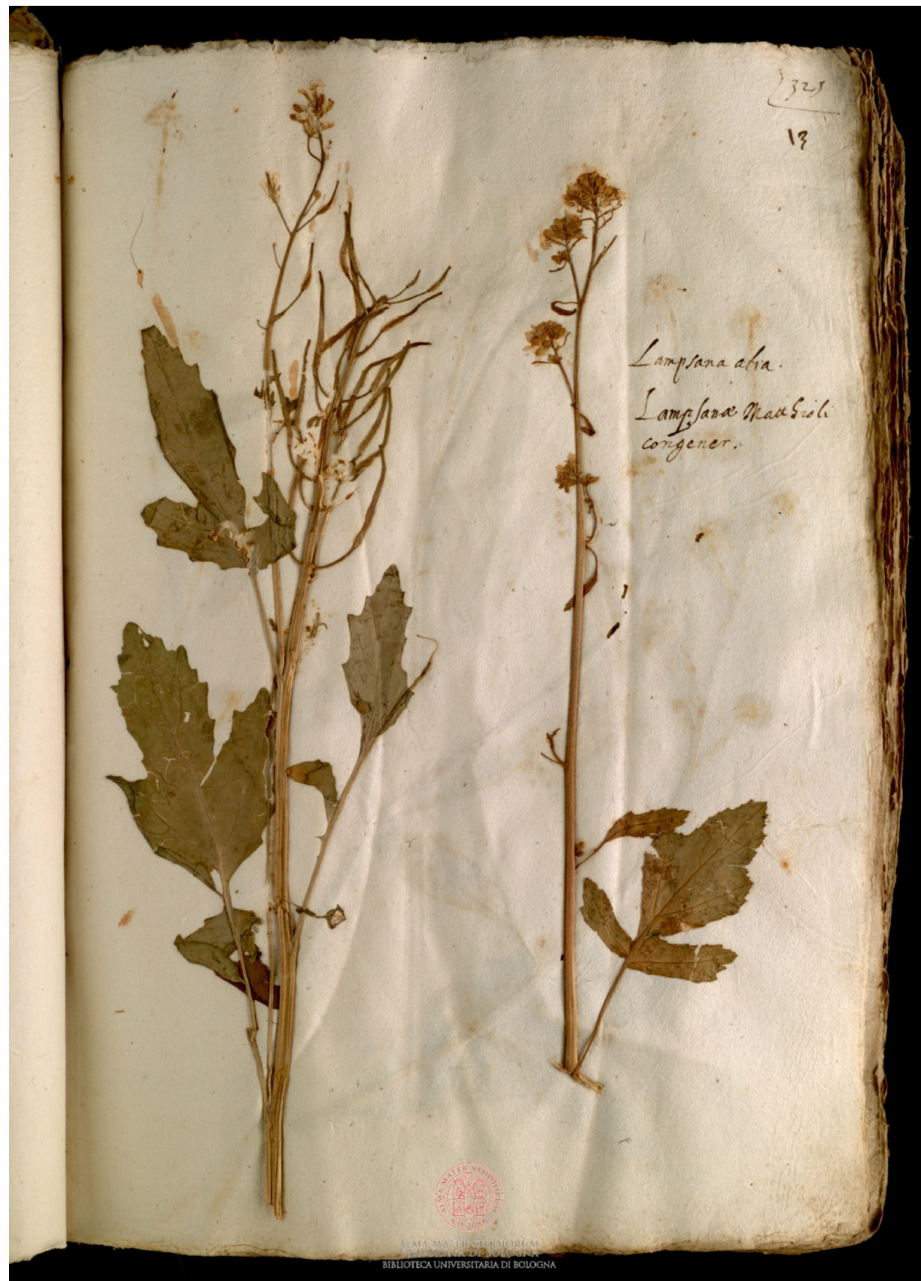
Figure 4. Specimen of Sinapis alba L. preserved in Erbario Aldrovandi, vol. IV, c. 13r.; on the sheet, “Lampsana alia, Lampsanæ Matthioli congener” is written. COPYRIGHT © Universit à di Bologna/Sistema Museale di Ateneo—Erbario e Orto